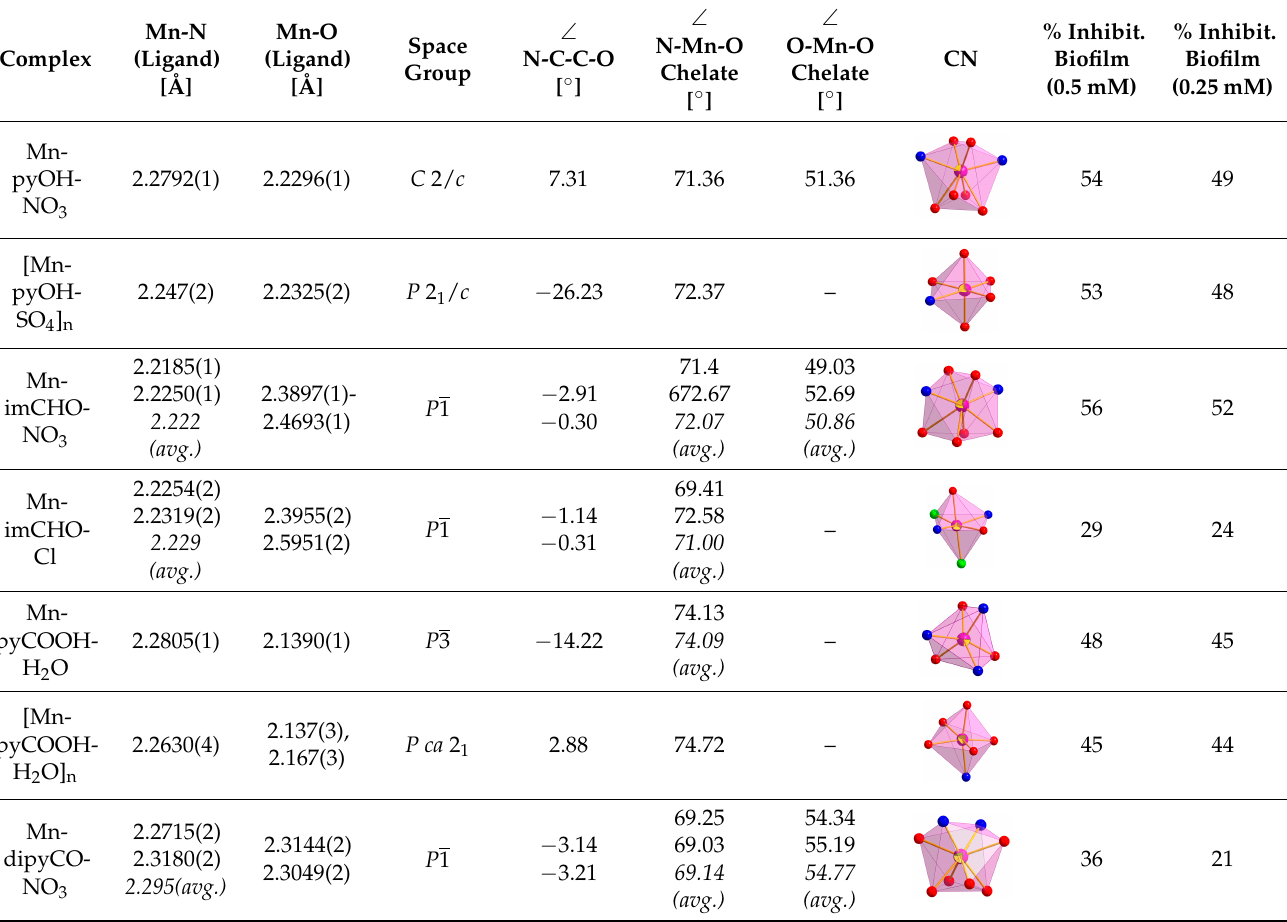
Table 3. Correlation between selected structural parameters and anti-biofilm activity for the Mn(II) complexes.